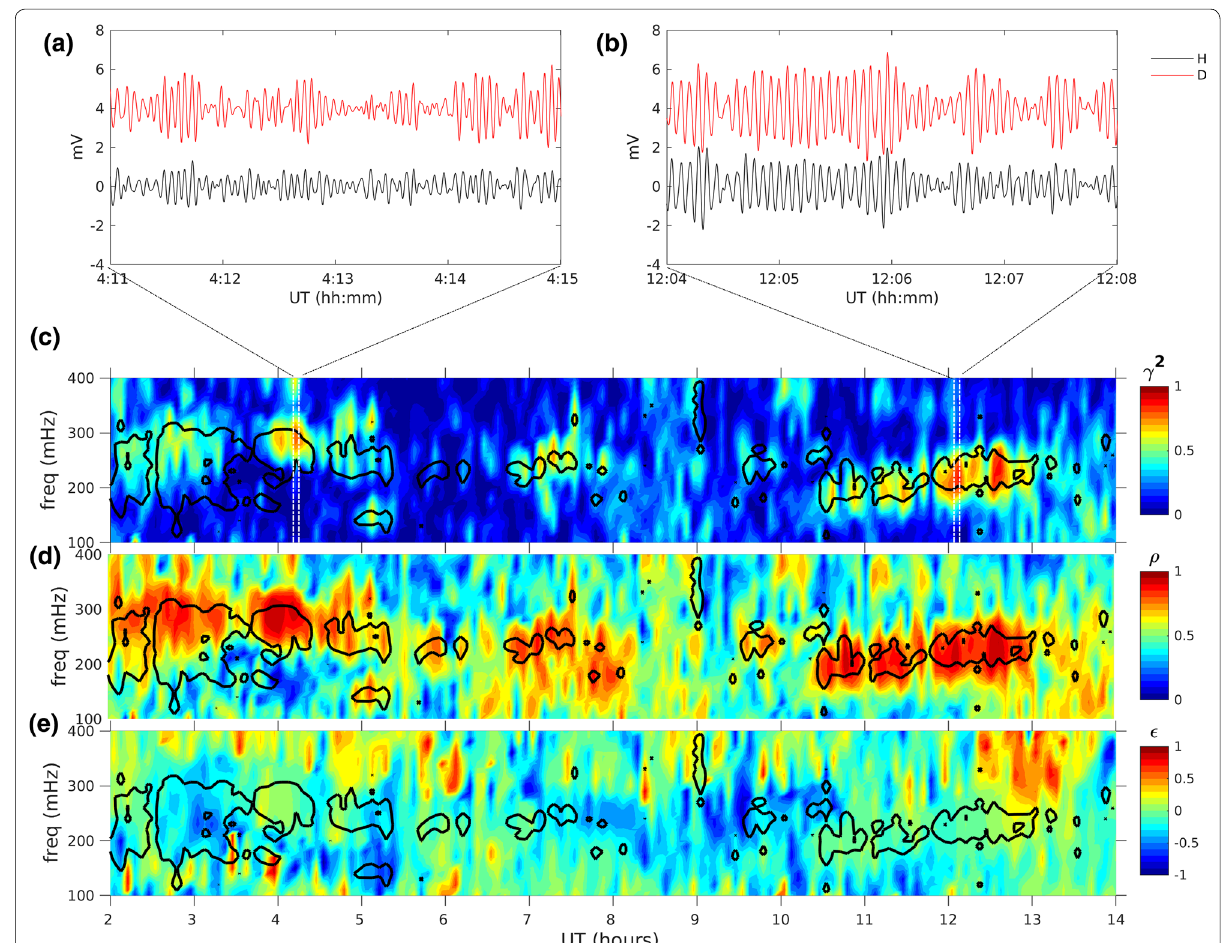
Fig. 2 Coherence (panel c ), polarization ratio (panel d ) and ellipticity (panel e ) of the magnetic field horizontal components at MZS on 22 February 2007 between 0200 and 1400 UT. Black contours indicate an SNR ( f ) greater than 3 at MZS (see Fig. 1). Panels a and b show details of 200–400 mHz filtered signals during two 4-min